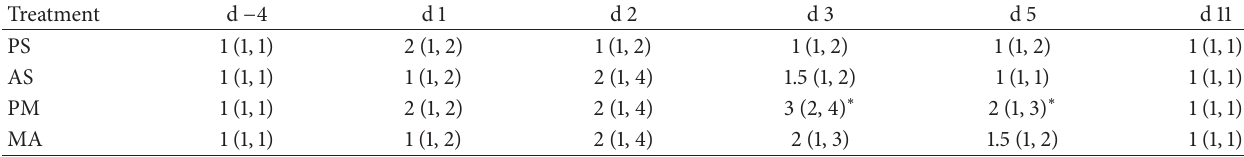
Table 1: Disease activity index of C57BL/6 mice ( 𝑛 = 8 /group) treated with PS, PM, AS, and MA. Treatment